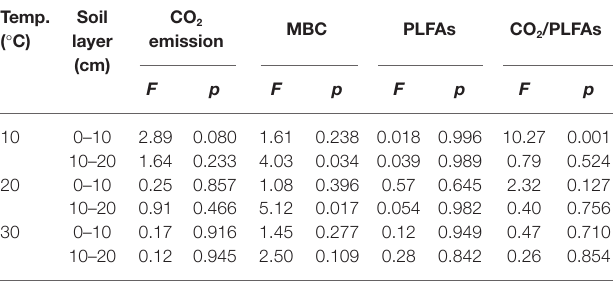
TABLE 2 | Statistical F and significance level p derived from one-way analyses of variances with nitrogen addition as the independent factor. Temp. ( ° C)